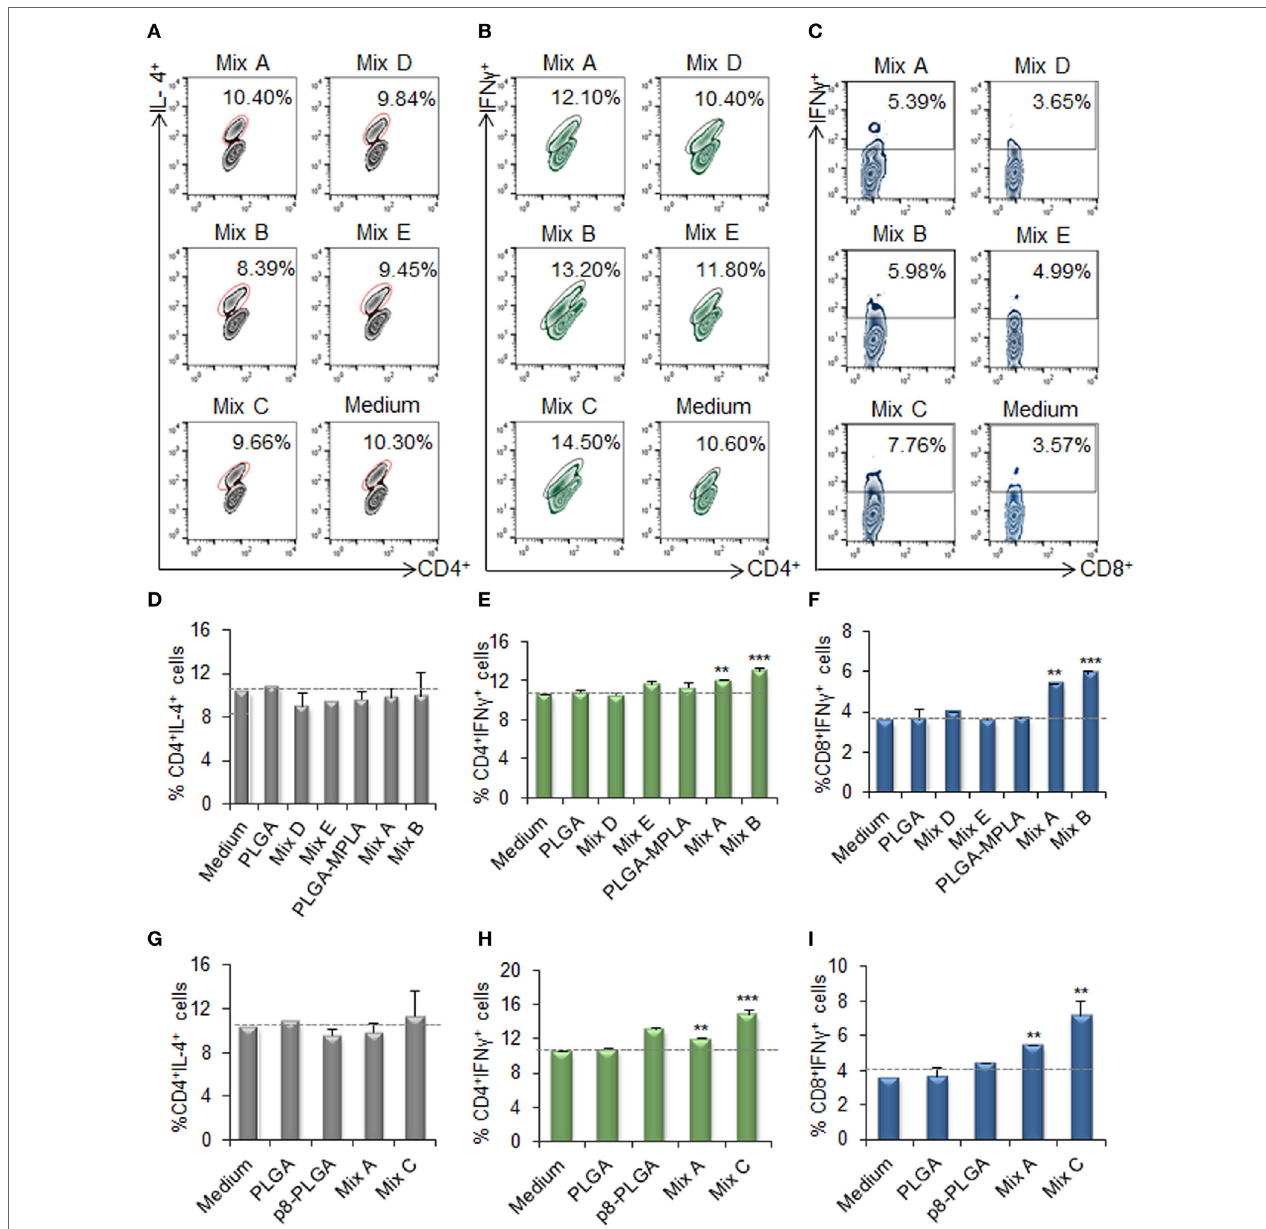
FigUre 7 | IFN γ -producing CD4 + and CD8 + T cells among the spleen cell populations primed by dendritic cells (DCs) stimulated with the mix B or C. Spleen cells from naïve BALB/c mice were primed in vitro by DCs stimulated for 24 h with the different mixes of differentially functionalized nanoformulations (mix A, mix B, and mix C), the mix of soluble chimeric peptides (mix D), and the mix of soluble chimeric peptides plus monophosphoryl lipid A (MPLA) (mix E). Then, spleen cells were stained and analyzed by flow cytometry. The representative contour plots depict IL-4-producing CD4 + T cells (a) , and IFN γ -producing CD4 + (B) , and CD8 + (c) T cells. Diagram showing the percentage of (D,g) IL-4-producing CD4 + T cells, (e,h) IFN γ -producing CD4 + , and (F,i) IFN γ -producing CD8 + T cells. Results are expressed as the mean ± SD and significant differences between T cells activated by DCs stimulated with mix A, mix B or mix C and T cells activated by unstimulated DCs are indicated by ** p < 0.01, or *** p <